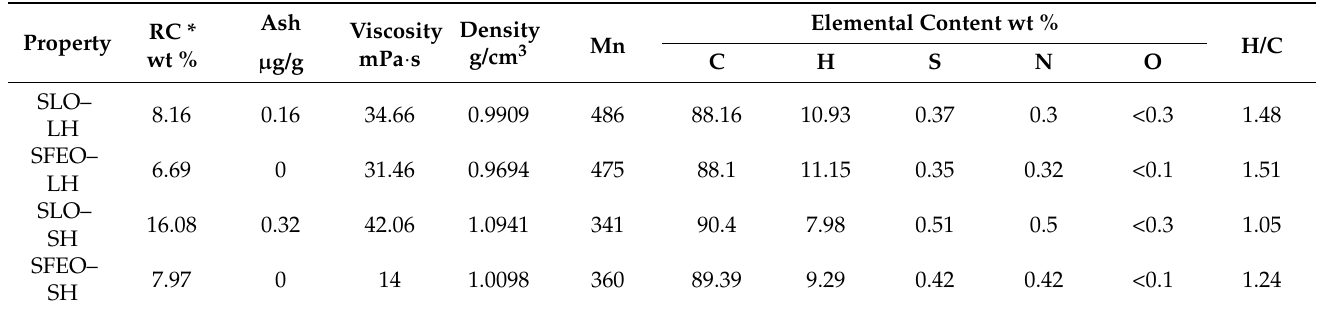
Table 3. Basic properties data of two kinds of SLO and SFEO.